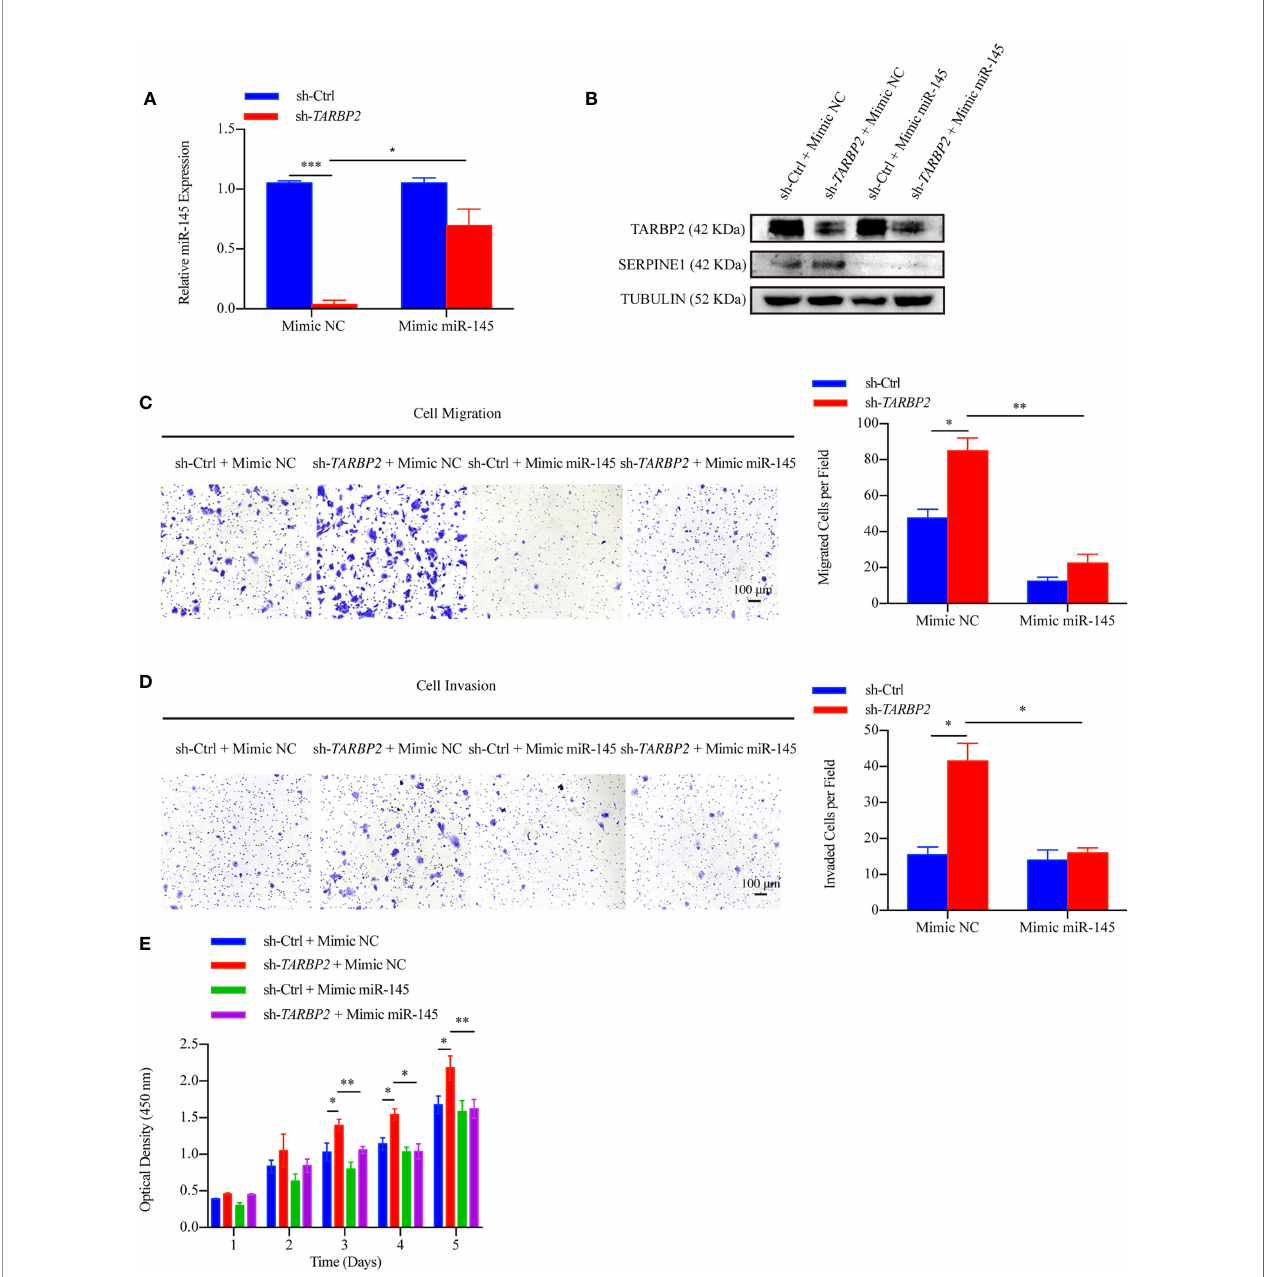
FIGURE 7 | miR-145 mediates SERPINE1 to affect the role of TARBP2 in HCC progression. (A) Levels of miR-145 in sh- TARBP2 HepG2 cells after treatment with Mimic NC and Mimic miR-145. (B) Protein levels of SERPINE1 and TARBP2 in the stable sh- TARBP2 HepG2 cells after treatment with Mimic NC and Mimic miR- 145. (C) Cell migration; (D) Invasion; and (E) Proliferation of sh- TARBP2 HepG2 cells treated with Mimic NC and Mimic miR-145. *p-value < 0.05; **p-value < 0.01; NC, negative